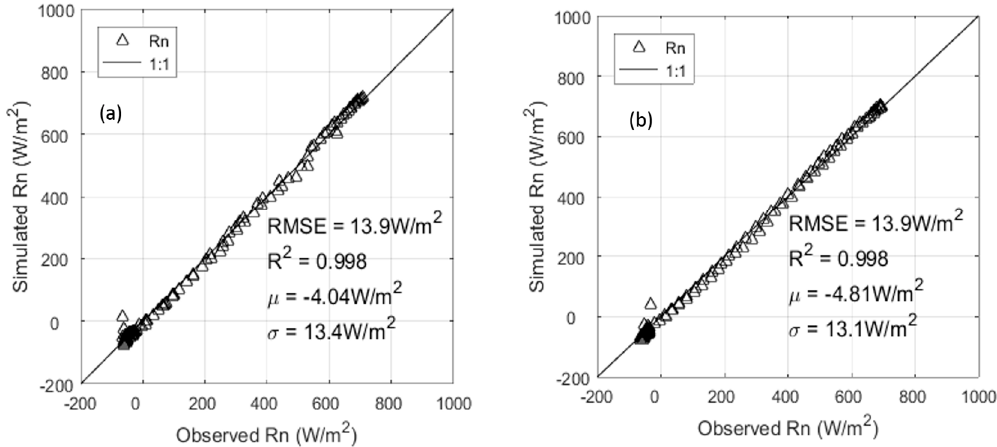
Figure 9. Scatterplots showing the relationship between the simulated and measured net radiation on ( a ) 10 July 2012 and ( b ) 2 August 2012. In total, 144 pairs of measurements were used for each day.